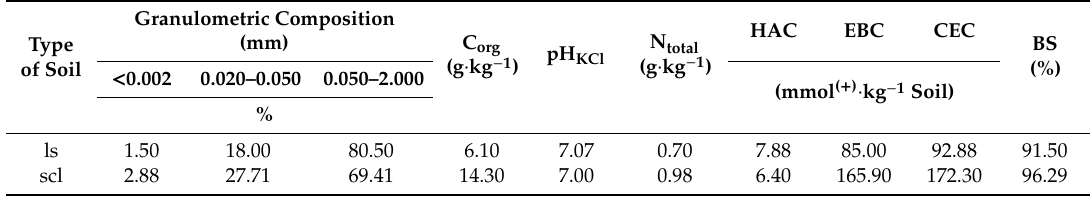
Table 1. Physicochemical properties of the soils used in the